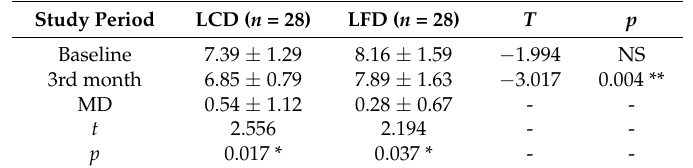
Table 5. Comparison of glycated hemoglobin (%) between the two groups in ITT. Study Period